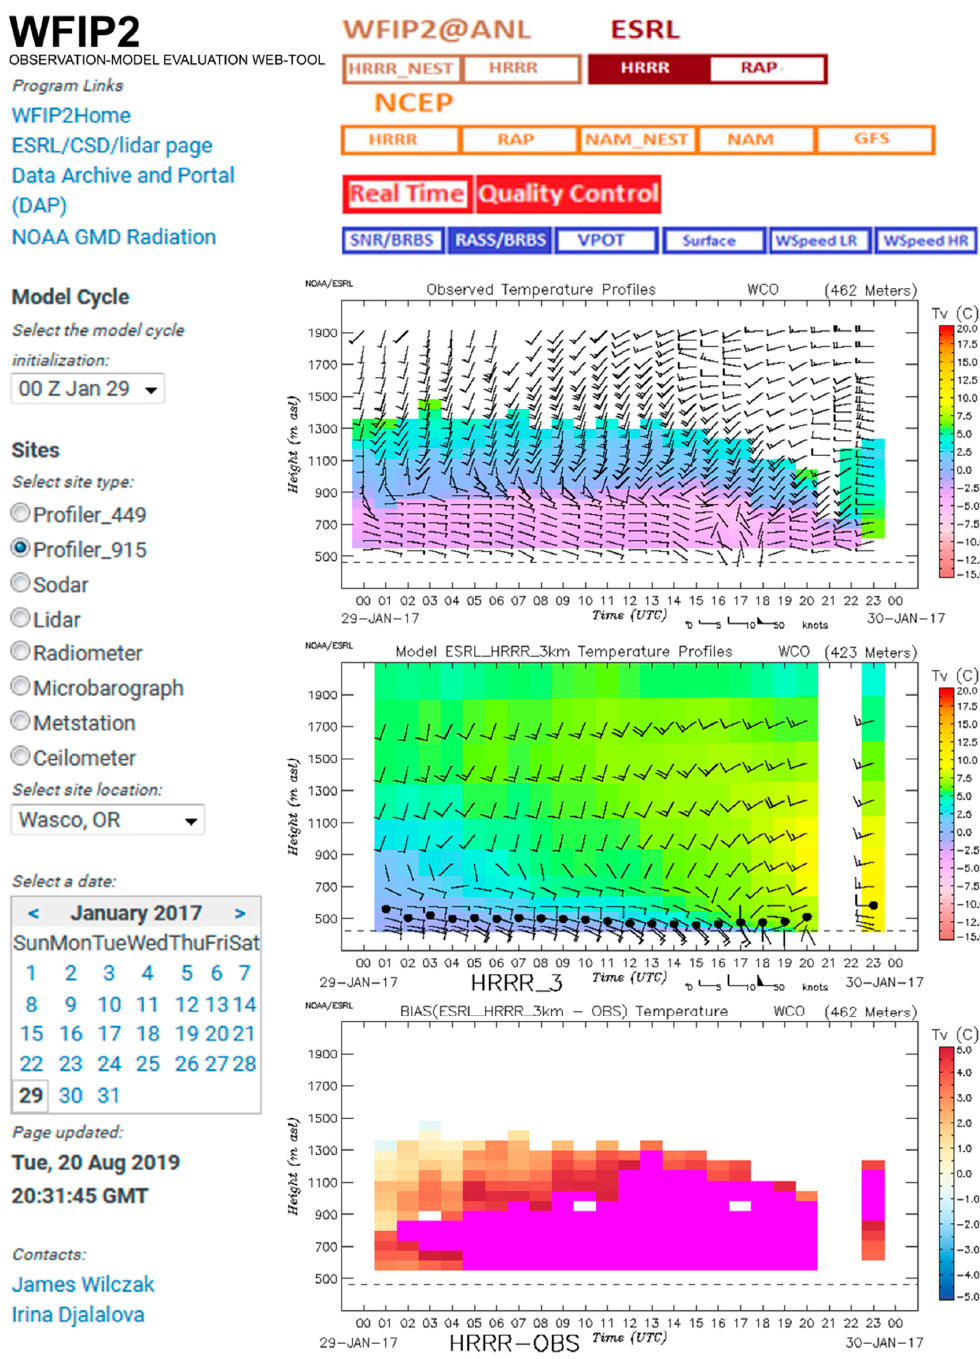
Figure 4. The WFIP2 real-time model-observation evaluation tool. The top panel shows the observed data, the virtual temperature by the RASS, with the winds measured by the 915-MHZ WP radar over-imposed). The middle panel shows the corresponding model data, the ESRL HRRR model forecast of virtual temperature. The bottom panel shows the difference between observed and model forecast. Inset map shows in red the location of the selected station (Wasco, OR). In-situ instrument data are displayed as time-series of the observations overlaid with the model forecasts (not shown). On the left of the web page, users can select other instrument types, the model initialization time (the start hour of the images), and the observing site and date of interest. On the top right, users can select the model to compare for validation. The cold pool event discussed in the text is illustrated. Data and image provided by the NOAA / OAR / ESRL PSD, Boulder, Colorado, USA: http: // wfip.esrl.noaa.gov / psd / programs / wfip2 /